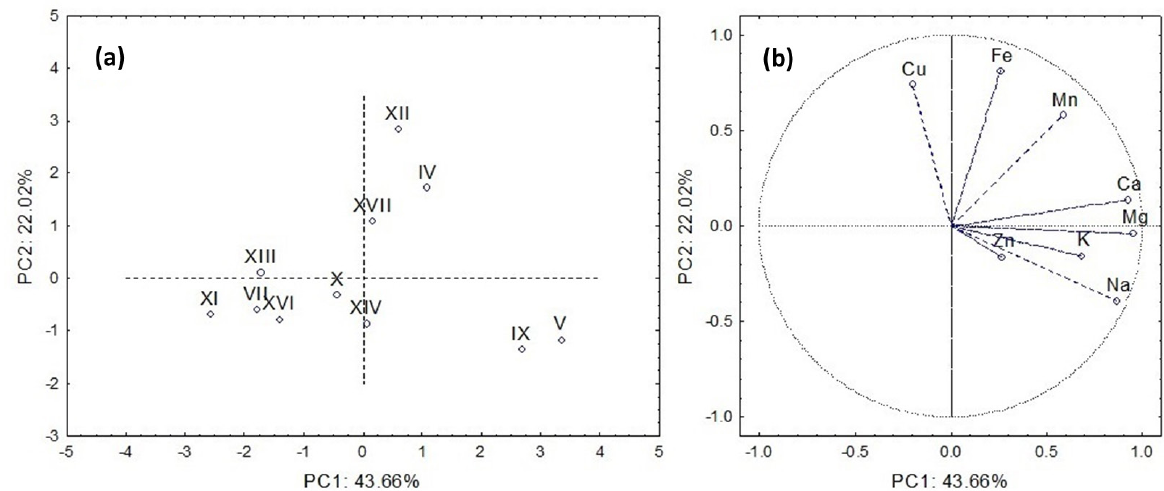
Figure 1. Score (a) and loading (b) plots of the two first principal components obtained from the evaluation of the mineral composition data by PCA.